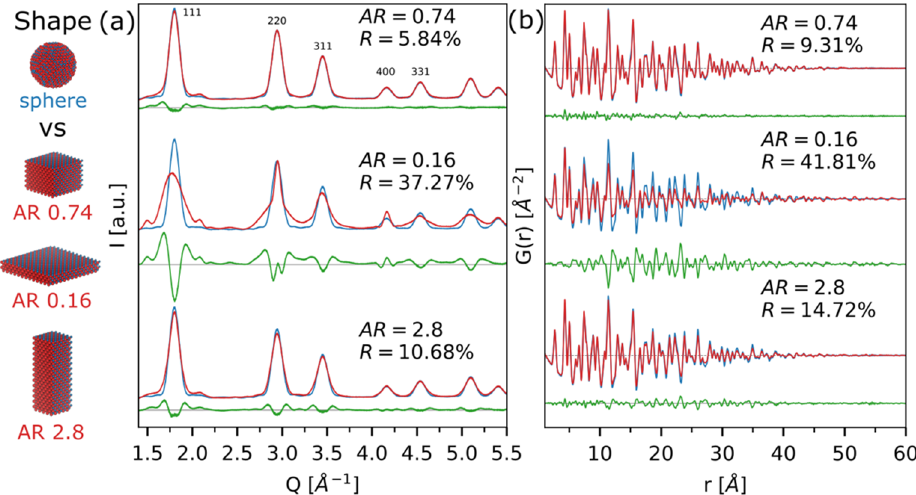
Figure 4. Comparison between simulations of spherical CdSe QDs ( <D> = 5.2 nm; σ / <D> = 7%, blue line) and different square prism morphologies with aspect ratios ( AR = L c / L a ) 0.7, 0.2, and 2.8 (red lines), both as DSE ( a ) and PDF ( b ). Differences against the reference spherical model are shown as green traces at the bottom of each plot, together with the corresponding agreement factors, R . Further details on the size and shape of CdSe atomistic models are given in Table S2.